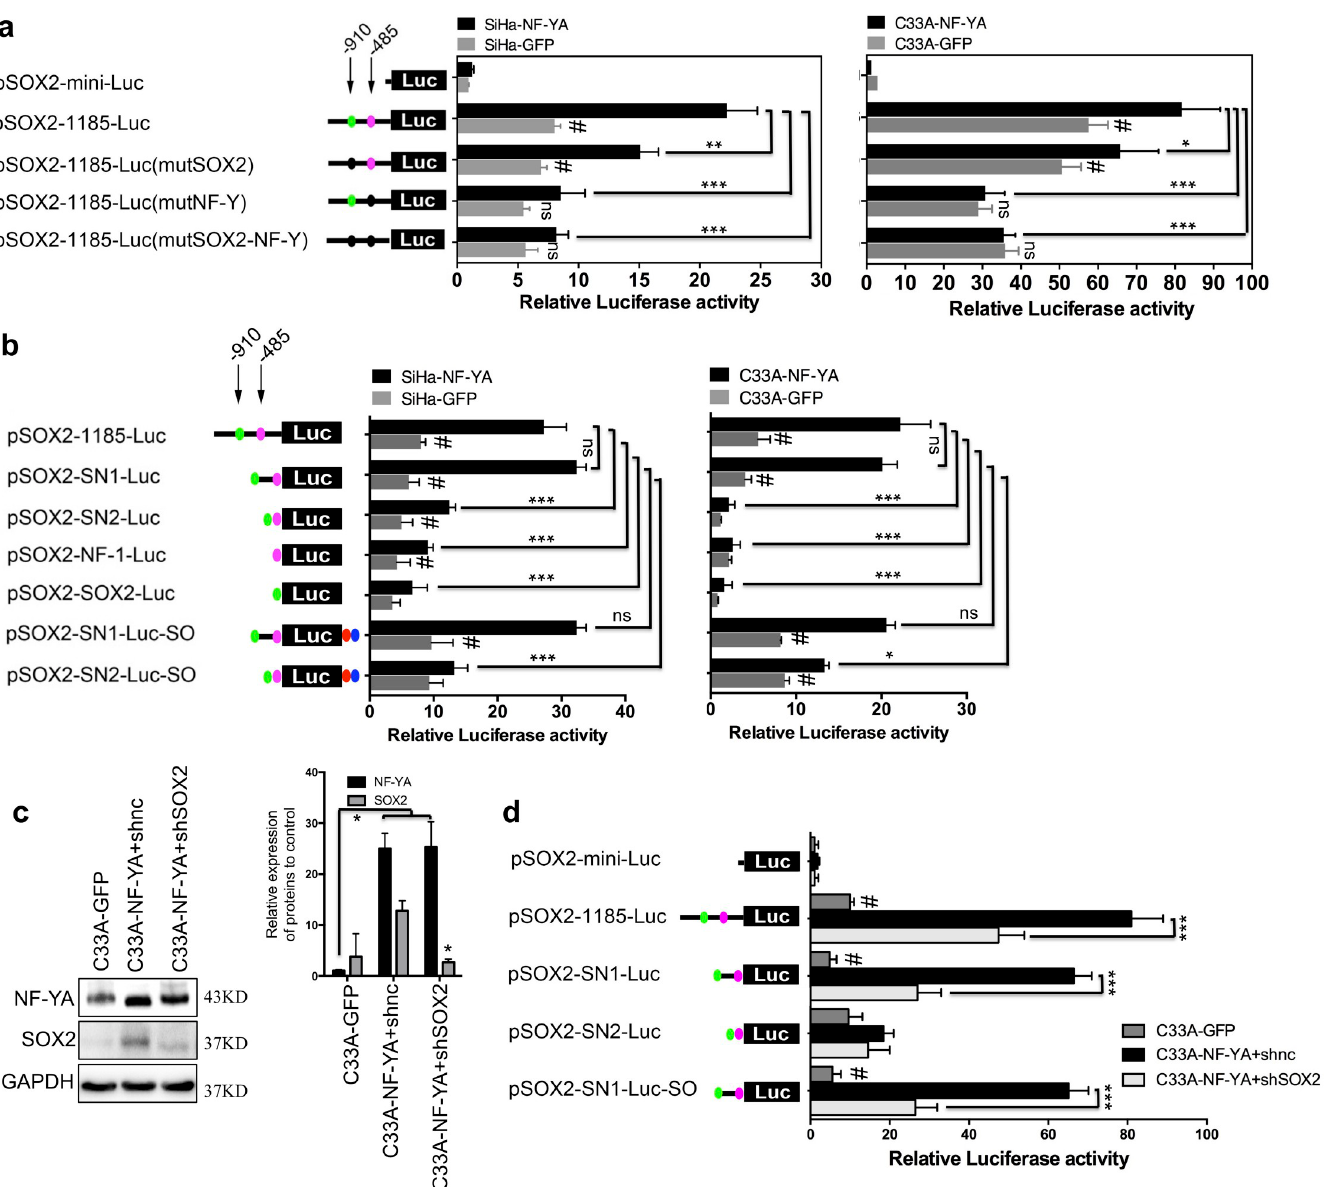
Fig 5. NF-Y specifically bound to CCAAT/ATTGG box upstream of the SOX2 promoter in cervical CSCs. (a) The luciferase activity of the SOX2 promoter mutations (green dot: SOX2 binding site; pink dot: NF-Y binding site; black dot: mutant of SOX2 or NF-Y binding site) in NF-YA-overexpressing SiHa and C33A cells. (b) The luciferase activity of the SOX2 promoter deletions in NF-YA-overexpressing SiHa and C33A cells. SOX2 was silenced by specific shRNA targeting the SOX2 CDS region in NF-YA-overexpressing C33A cells (c) and the luciferase activity of SOX2 promoter deletions was measured (d). (e) The diagram of NF-YA and SOX2 binding sites upstream of the SOX2 promoter. Data is presented as the mean ± SD of experiments in triplicate and statistically analyzed with student’s t -test. The symbols represent the following: � , p < 0.05; ��� , p < 0.001; #, NF-YA group vs GFP group and p < 0.05; ns, no statistical